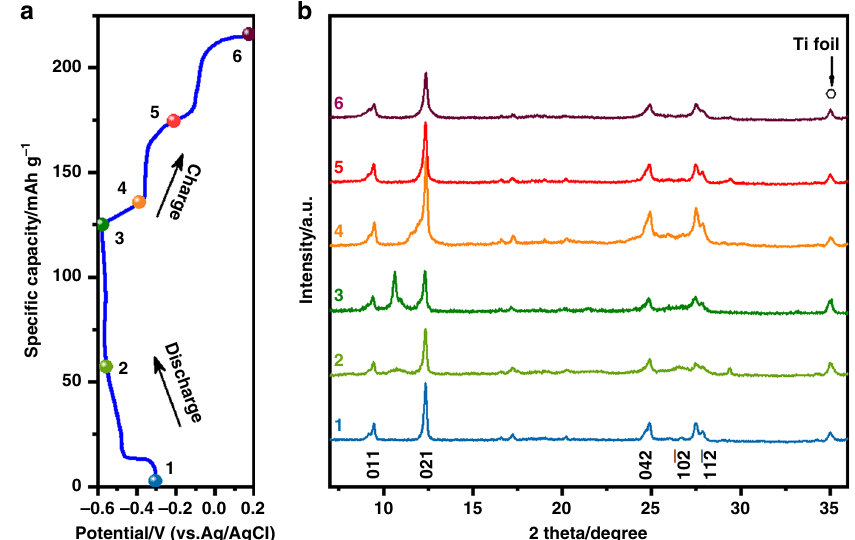
Fig. 3 Structural evolution of PTCDA during MV 2 + intercalation. a GCD potential pro fi les of the PTCDA electrode in the fi rst cycle; b Ex situ XRD patterns of the PTCDA electrode recorded at different